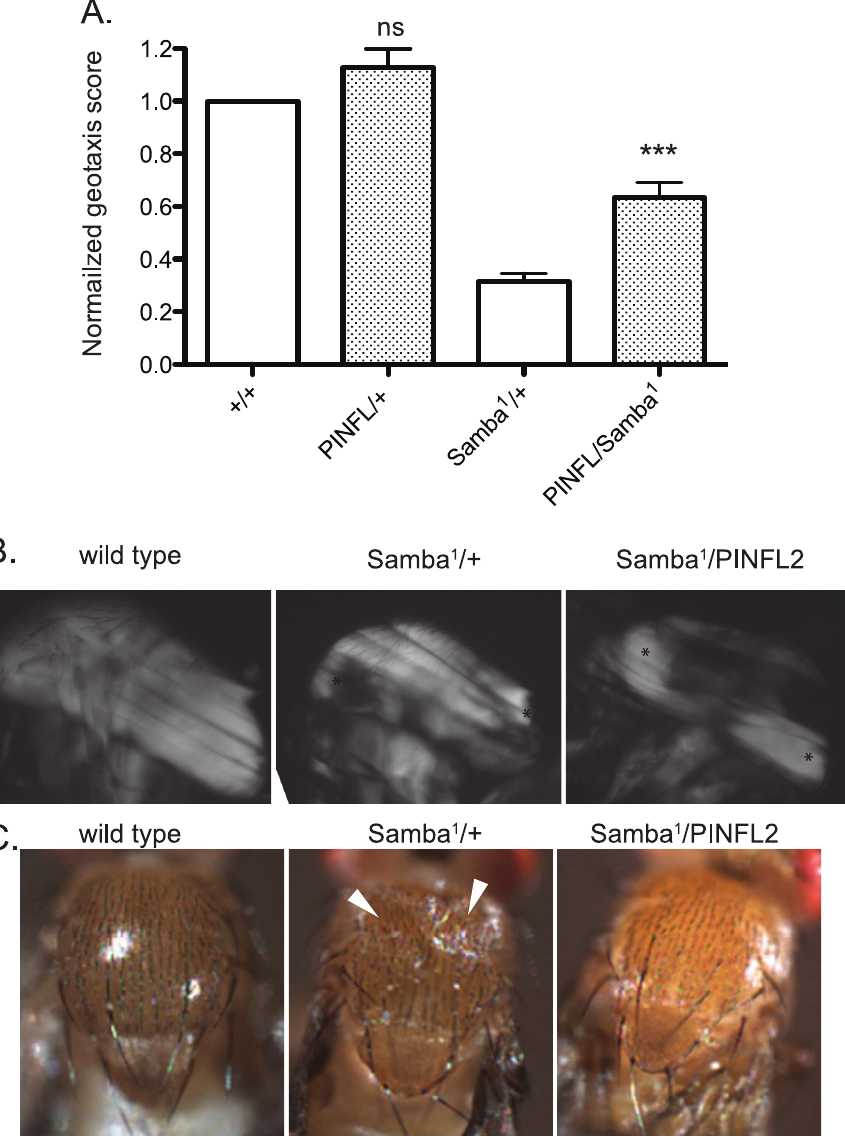
Figure 7. Increased expression of PINCH-Flag rescues geotaxis defects and thoracic indentation, but does not reverse hypercontraction of the IFM in the Samba 1 mutant. A) For each genotype, a normalized geotaxis score from . 5 independent assays is plotted as the mean 6 SEM. *** indicates p , 0.001 and ns indicates p . 0.05 when compared to the corresponding control data. B) Representative polarized light images of thoraces show that the IFM in the Samba 1 mutant exhibits hypercontraction that is not rescued upon expression of PINCH- Flag. Asterisks indicate areas of hypercontraction within the structure of the IFM. C) A dorsal view shows that the thoracic indentations prevalent in Samba1/ + adults are rescued upon expression of transgenic PINCH-Flag. White arrowheads indicate the areas of indentation.